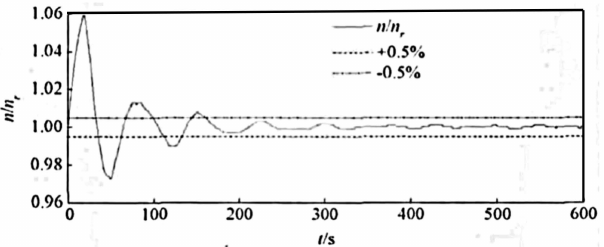
Figure 19. Fluctuation process of the rotational speed of a hydropower plant with an SCTT and a damping well under step load disturbance